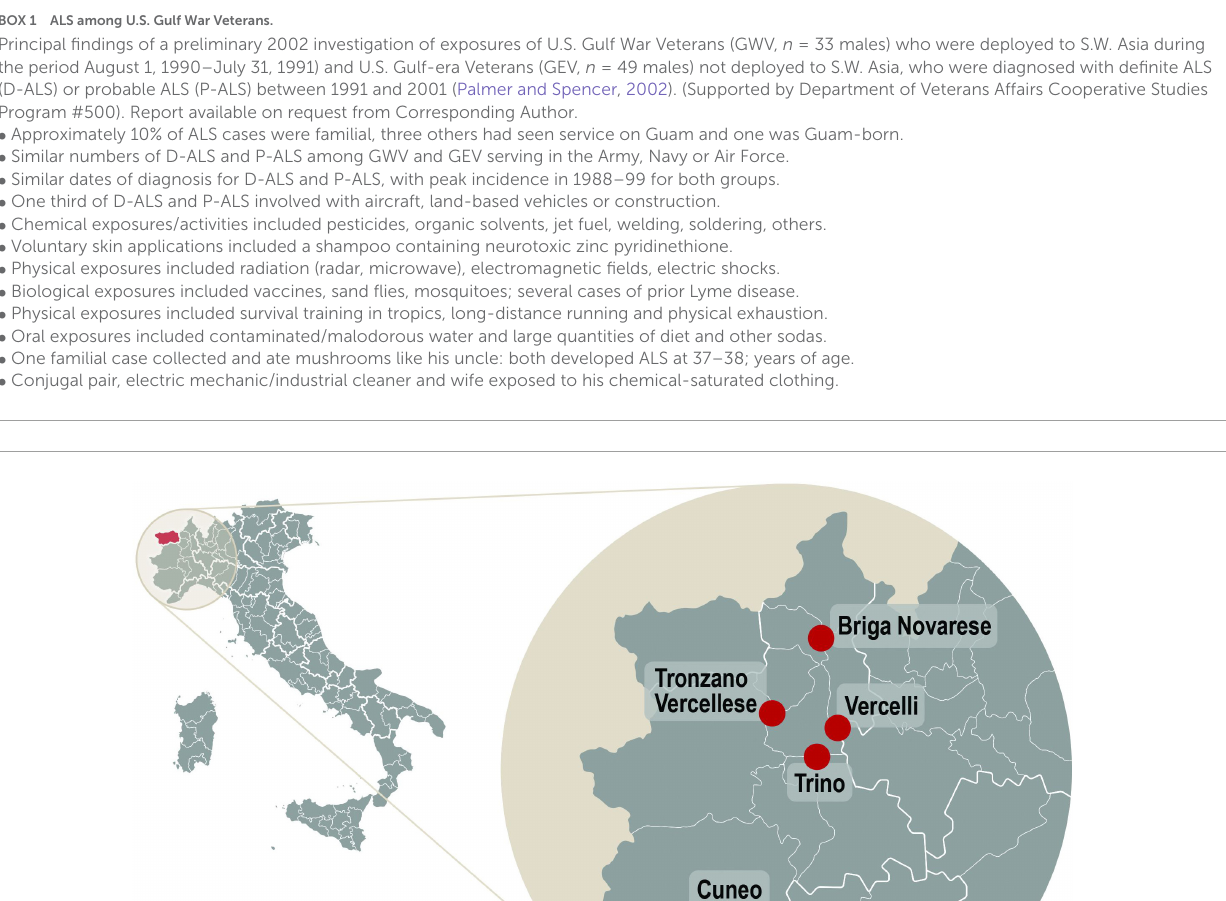
sharp rise in foraging for wild mushrooms across Sardinia along with an increase in the number of acute (but unspecified) intoxications, few of which have proved fatal (Comandini et al., 2018). Noteworthy is that images #11 and #21 in an historical treatise on the hypogeous fungi of Sicily and Sardinia (Mattirolo, 1900) depict False Morels ( Gyromitra